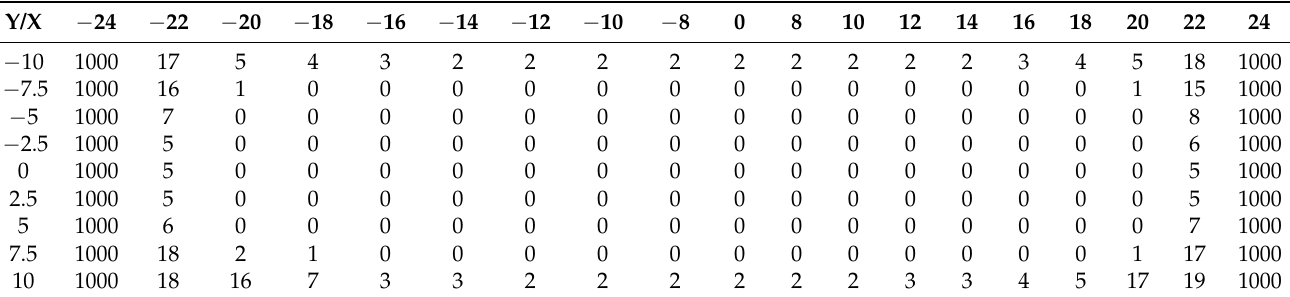
Table 4. Incorrectly transmitted messages per position at 45°.